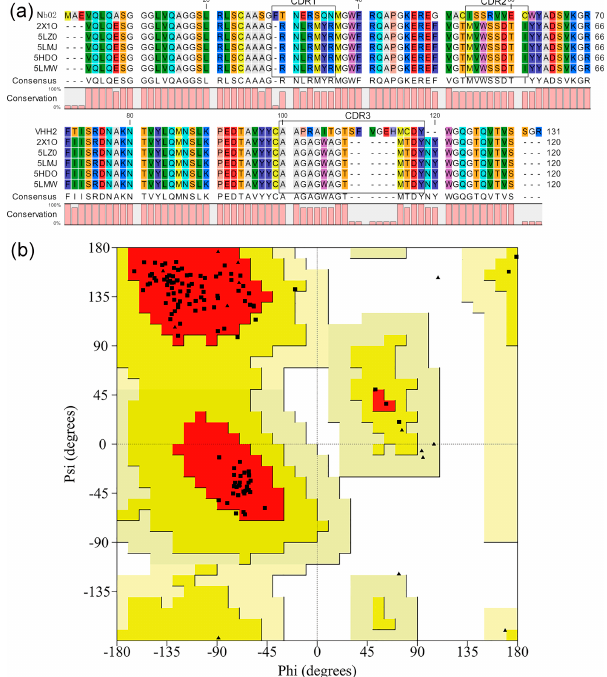
Figure 1. Three-dimensional (3D) structure building and assessment of Nb02. ( a ) Structural alignment of templates used in this study. ( b ) Main residues Ramachandran plot of Nb02. The squares represent the main residues, and the triangles represent G and P.